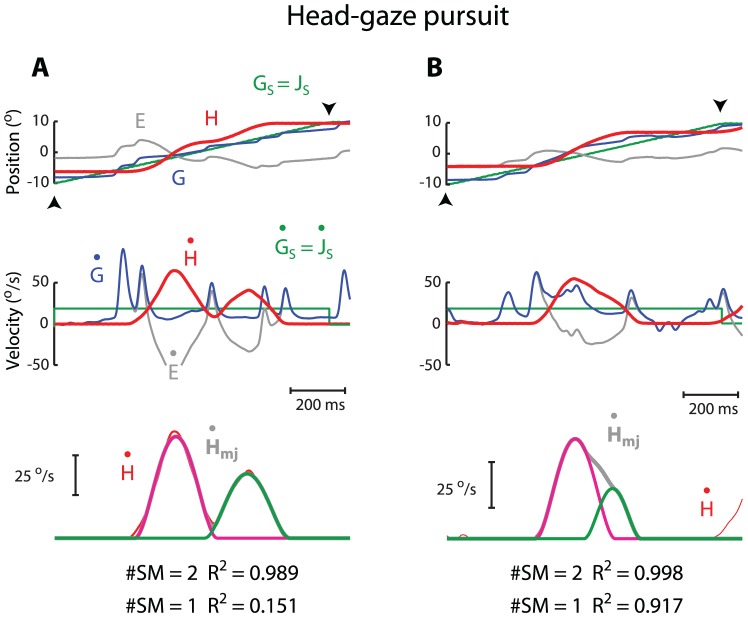
Two examples of submovement composition of head movement during head-gaze pursuit.Note the goodness of fit in A improved by 83.8% from one single submovement (#SM = 1; 84.9% error) to 2 overlapping submovements (#SM = 2; 1.1% error). The goodness of fit in B improved by 8.1% from a single submovement (#SM = 1; 8.3% error) to 2 overlapping submovements (#SM = 2; 0.2% error). Format after Figure 2.